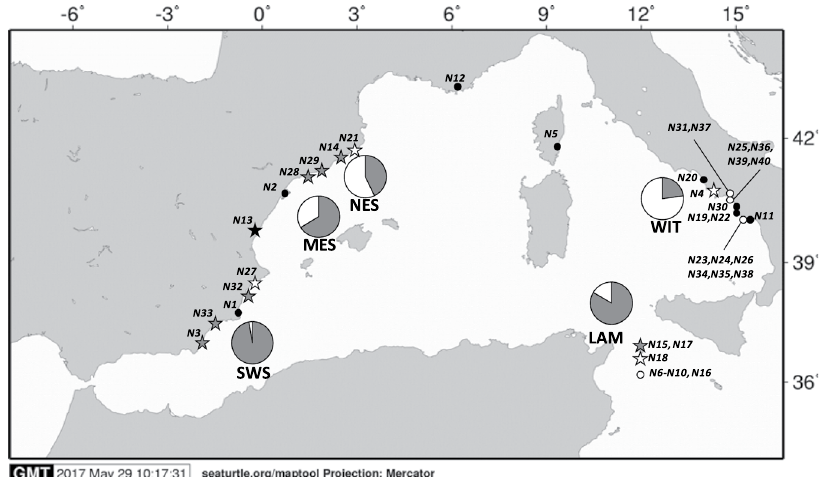
Figure 1. Western Mediterranean sporadic nests and foraging areas. Location of the sporadic nesting events coded as in Table 1. Stars indicate nesting events with genetic data and reliable assignation to the Atlantic (grey), to the Mediterranean (white) or mixed (black). White dots indicate nesting events with genetic data but with no reliable assignment due to resulting low ( < 0.80) probabilities or due to not having microsatellite data when published 64 . Black dots indicate nesting events without genetic data. Pie graphs show the percentage of Atlantic (grey) and Mediterranean (white) turtles visiting the developmental foraging grounds located in the vicinity of the sporadic nesting events. SWS: south Western Spain; MES: mid Eastern Spain; NES; north Eastern Spain; WIT: Western Italy; LAM: Lampedusa 43–46,52,71 . Map created using the free software MAPTOOL (SEATURTLE. ORG Maptool. 2002. SEATURTLE.ORG, Inc. http://www.seaturtle.org/maptool/ 29 May 2017), that uses GMT (The Generic Mapping Tool) 99